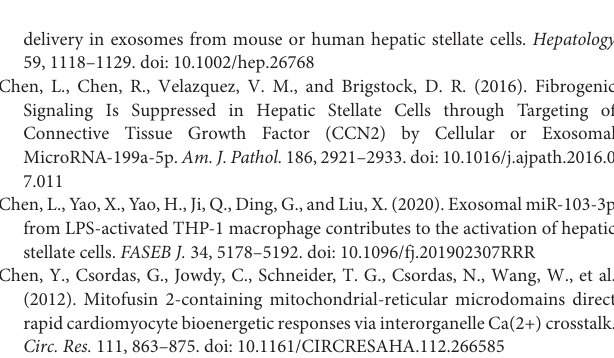
Supplementary Figure 1 | The western blot quantitation for Figure 5E . Supplementary Figure 2 | The western blot quantitation for Figure 5F